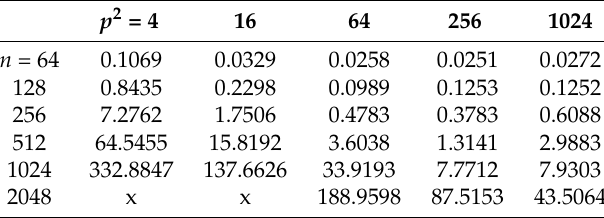
Table 1. Time measurements on